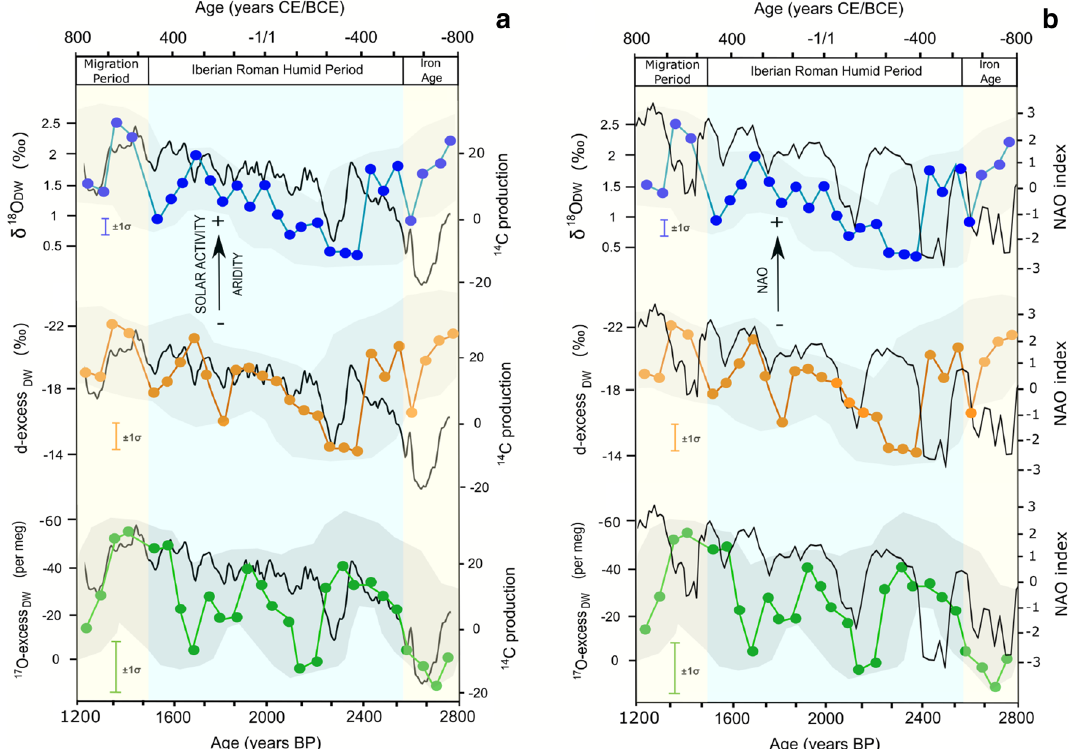
shades represent the time-series 95% confidence interval of the proxies obtained by the COPRA code 21 that combine analytical errors of stable isotope measurements and the age model